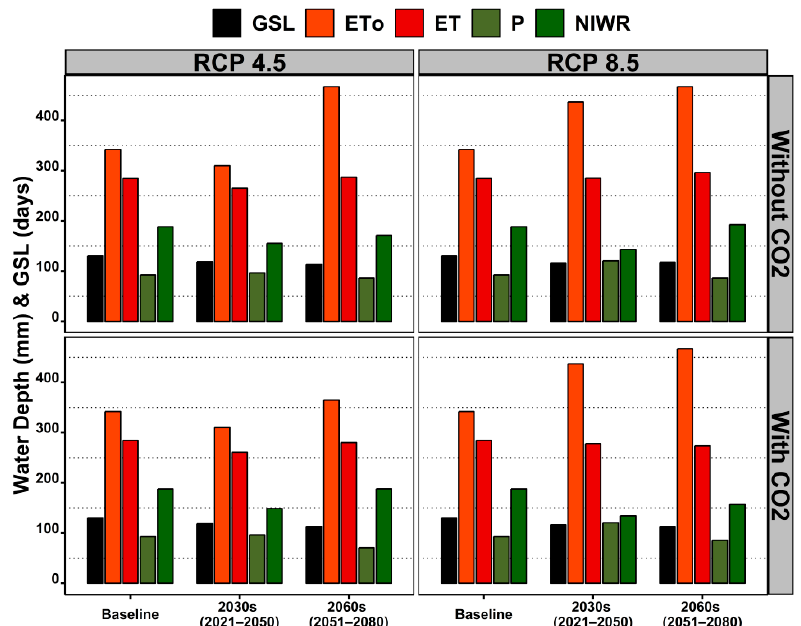
Figure 7. Average growing season length (GSL), reference crop evapotranspiration (ET o ), actual crop evapotranspiration (ET), rainfall (P) and net irrigation water requirement (NIWR) for wheat during the baseline and future time slices. Each bar compares the baseline average values with the mean value of nine GCMs.